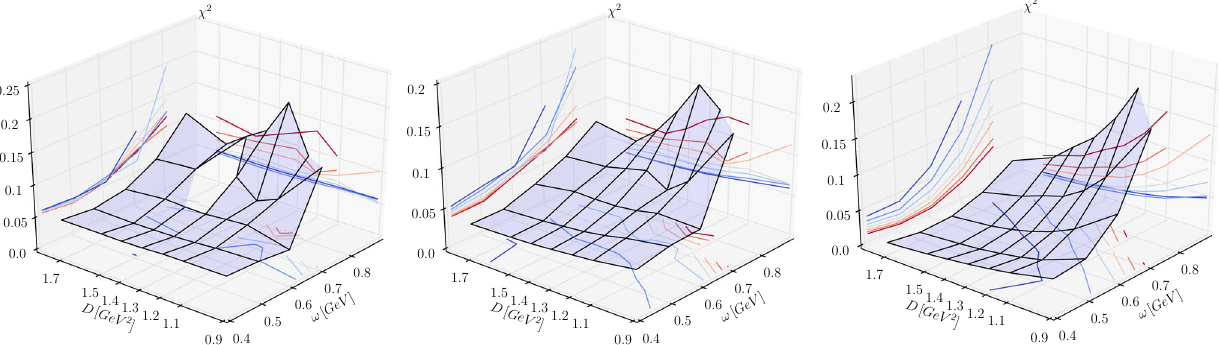
Fig. 21 χ 2 plot from the comparison of our calculated and the experimental other splitting as a function of ω and D . Left panel Combination of all “other” splittings (see text); center panel combination of a subset of four splittings (see text); right panel ( [ 0 ++